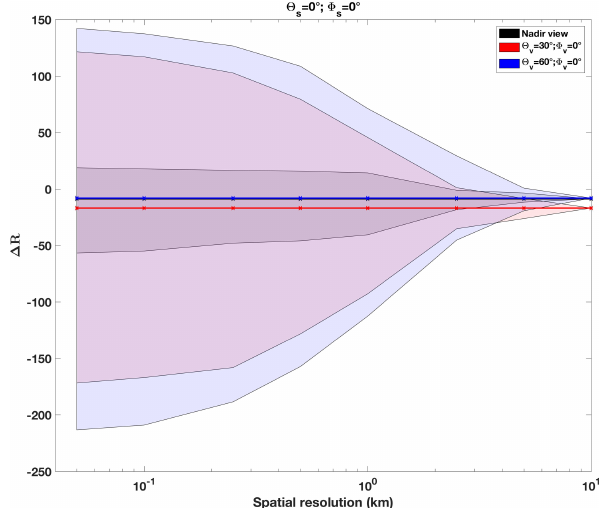
Figure 14. 3-D effects as a function of the spatial resolution relative to the 3-D reflectances in percentage. The shaded areas correspond to the range of relative reflectance differences estimated for the 10th and 90th percentiles, and the solid lines correspond to the average differences for a different pair of viewing zenith and azimuth angles (cid:50) v and (cid:56) v